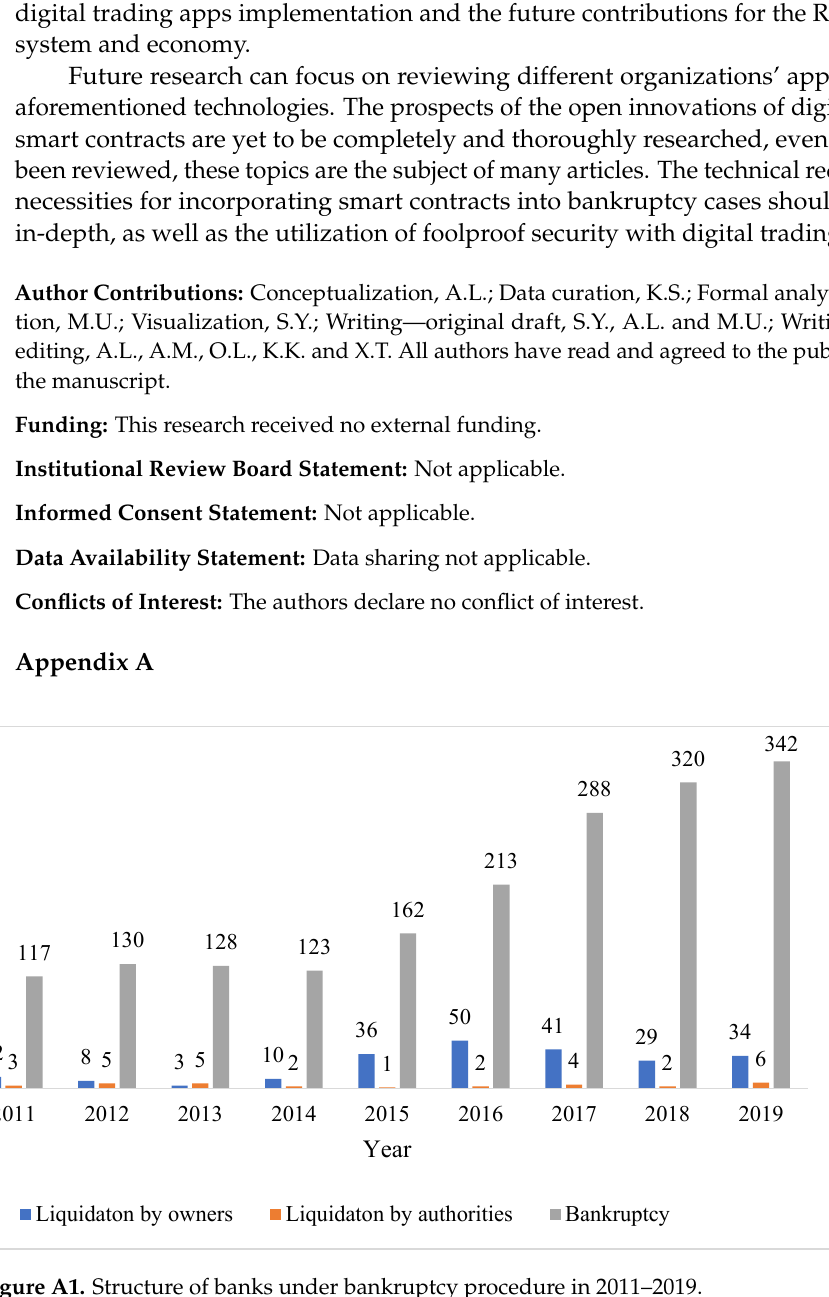
Figure A2. Banks currently proceeding in bankruptcy cases in 2018–2019. Table A1. Estimated correlations. №